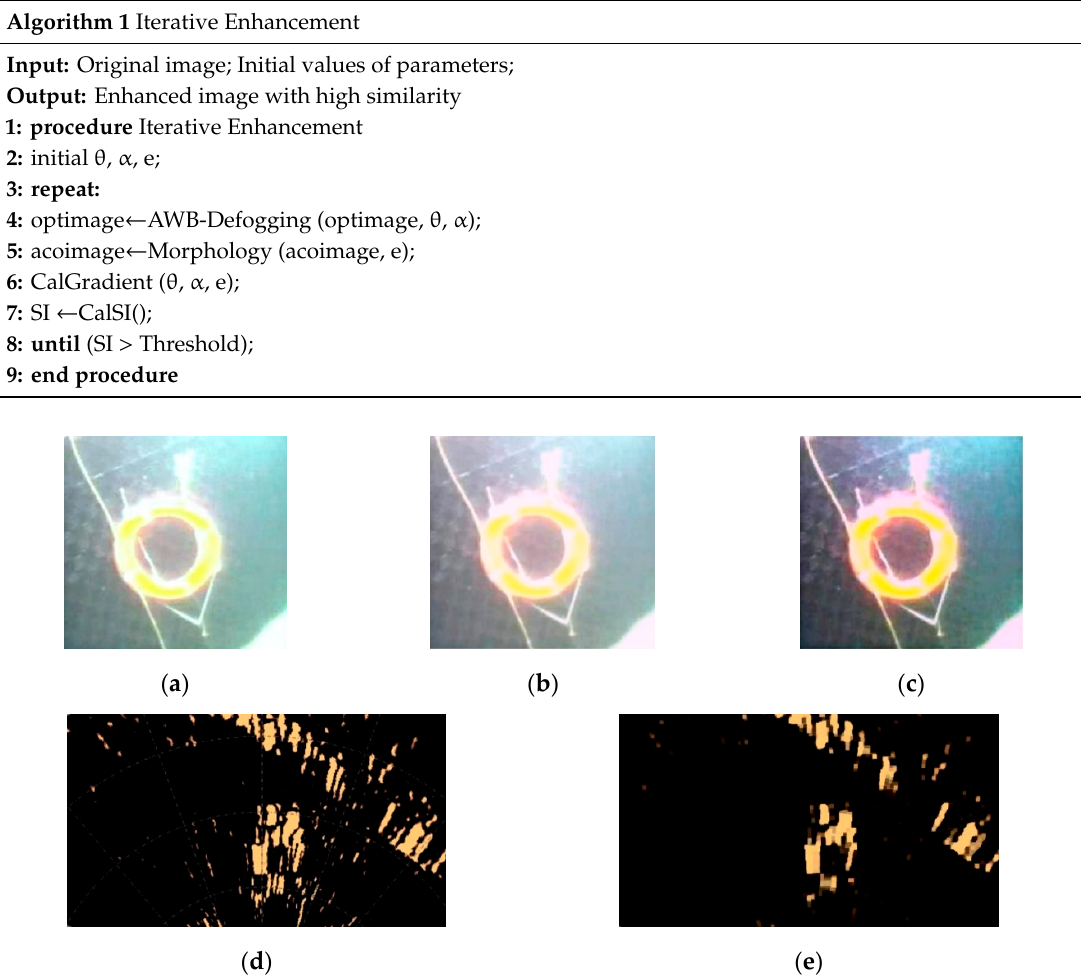
Figure 2. (a ) The original optical image; ( b ) the image after color consistency enhancement; ( c ) the image after defogging; ( d ) the original acoustic image; ( e ) the image after noise reduction.